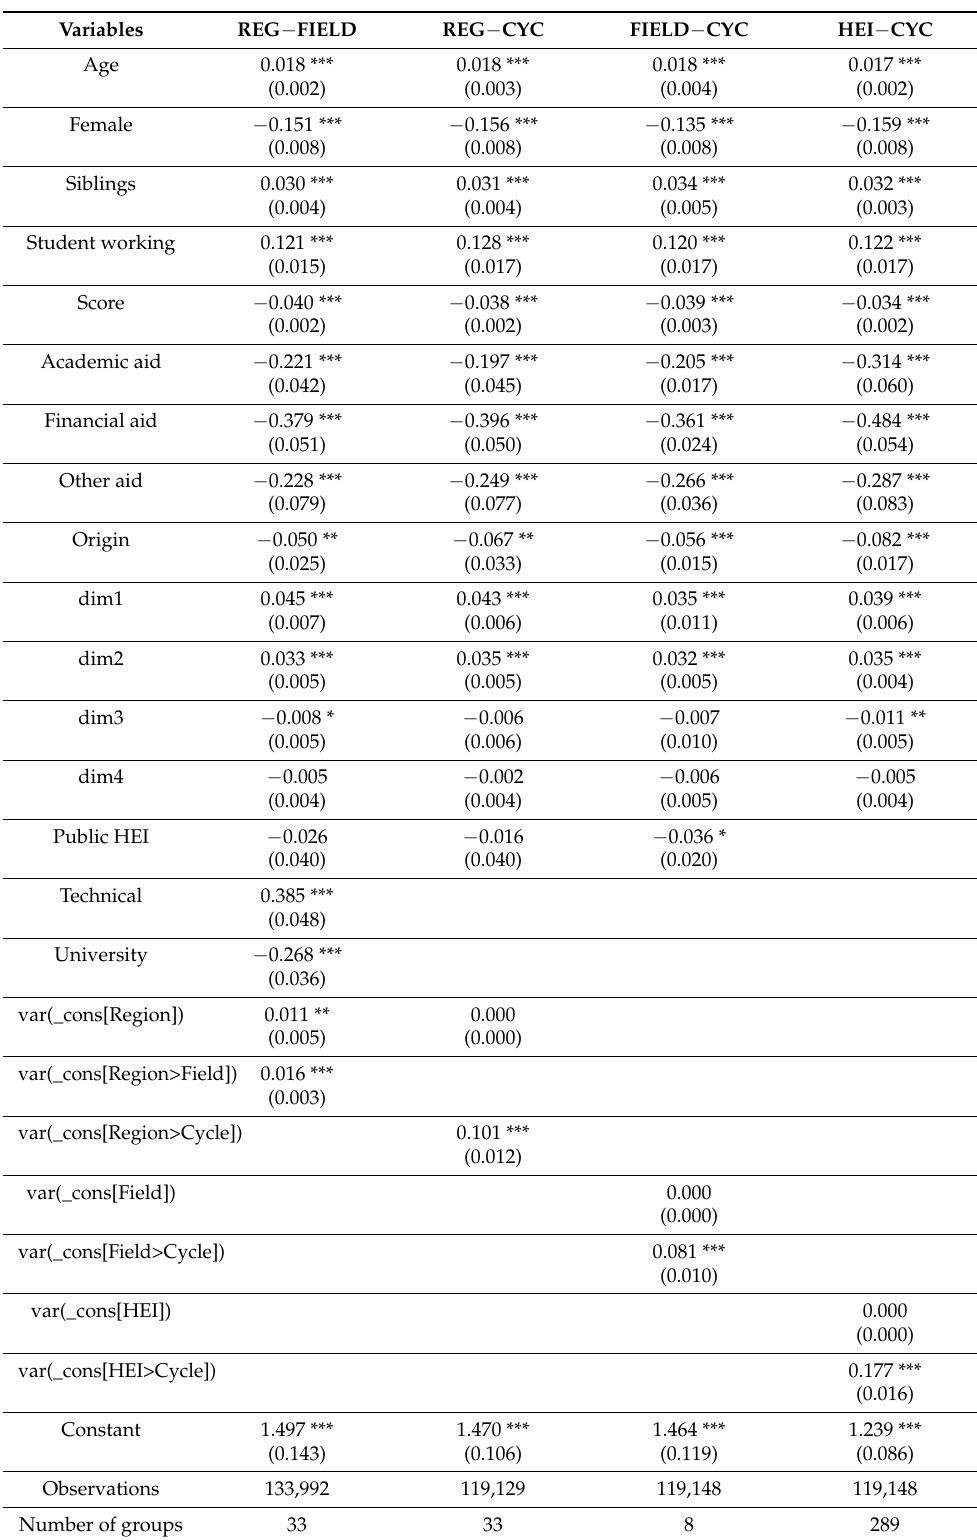
Table 6. Dropout estimation results (three